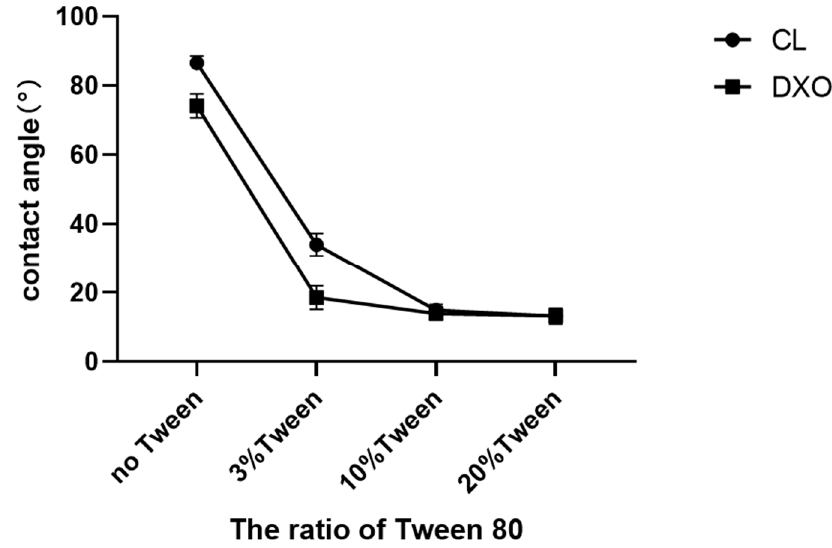
Table 1. The water contact angle results measured on the film samples.